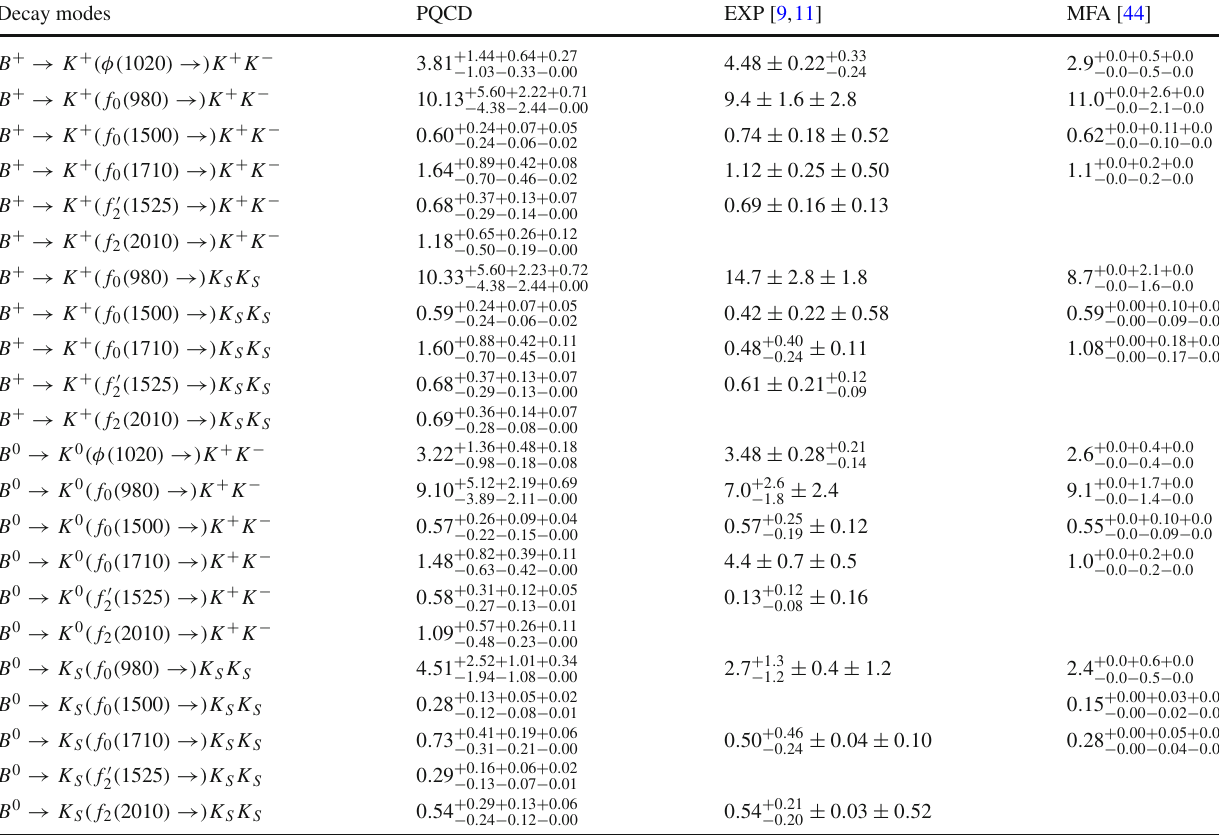
Table 1 CP averaged branching ratios (in 10 − 6 ) of B → K + / 0 ( R → ) K + K − / K S K S decays in PQCD approach together with experimental data [9,11]. The results from a model based on the factorization approach(MFA) are from Ref. [44] Decay